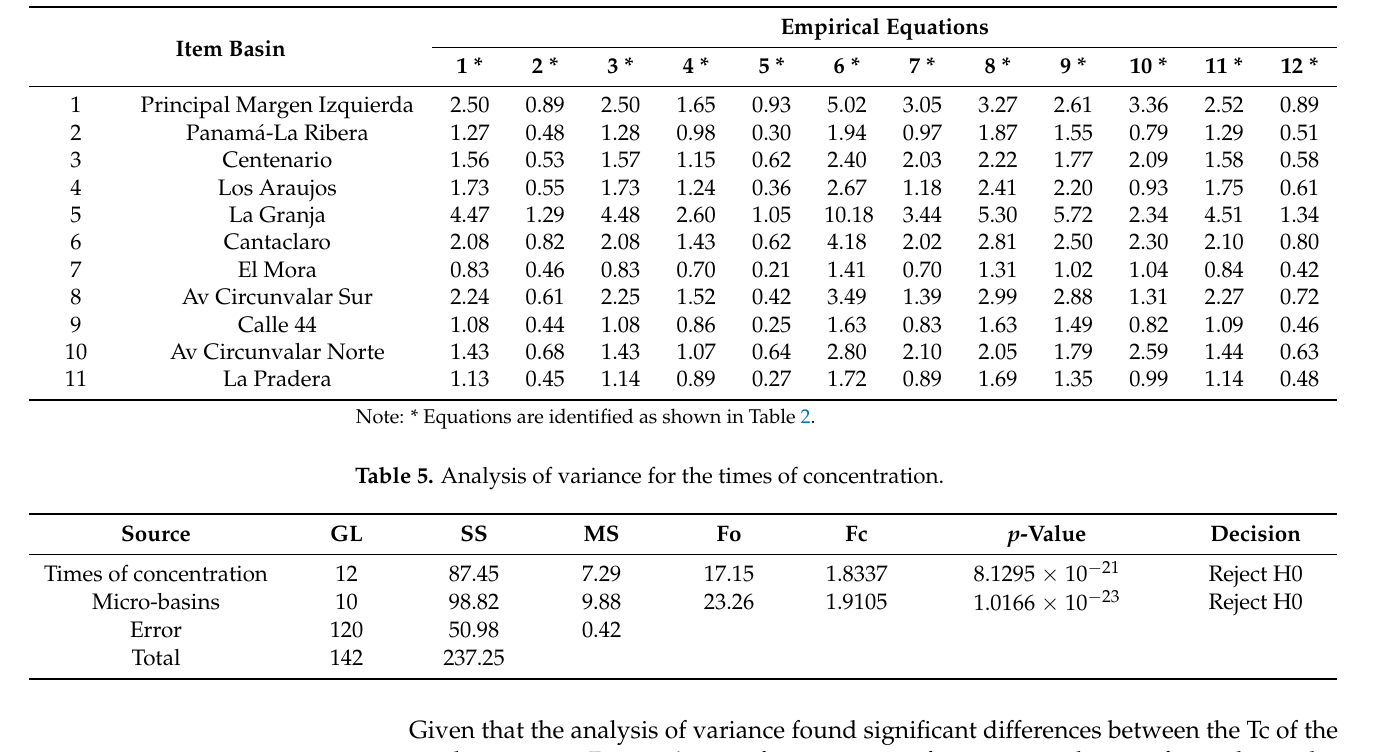
Table 4. Tc calculation (h) by empirical methods.